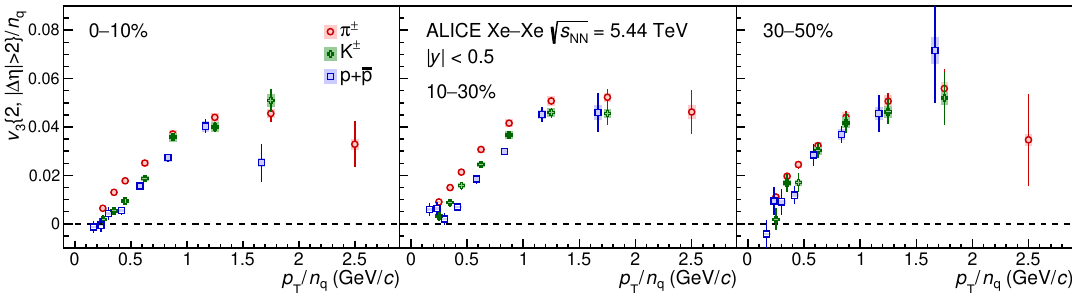
Figure 7. The p T /n q dependence of v 3 /n q of π ± , K ± , and p+ p for various centrality classes. Bars (boxes) denote statistical (systematic)